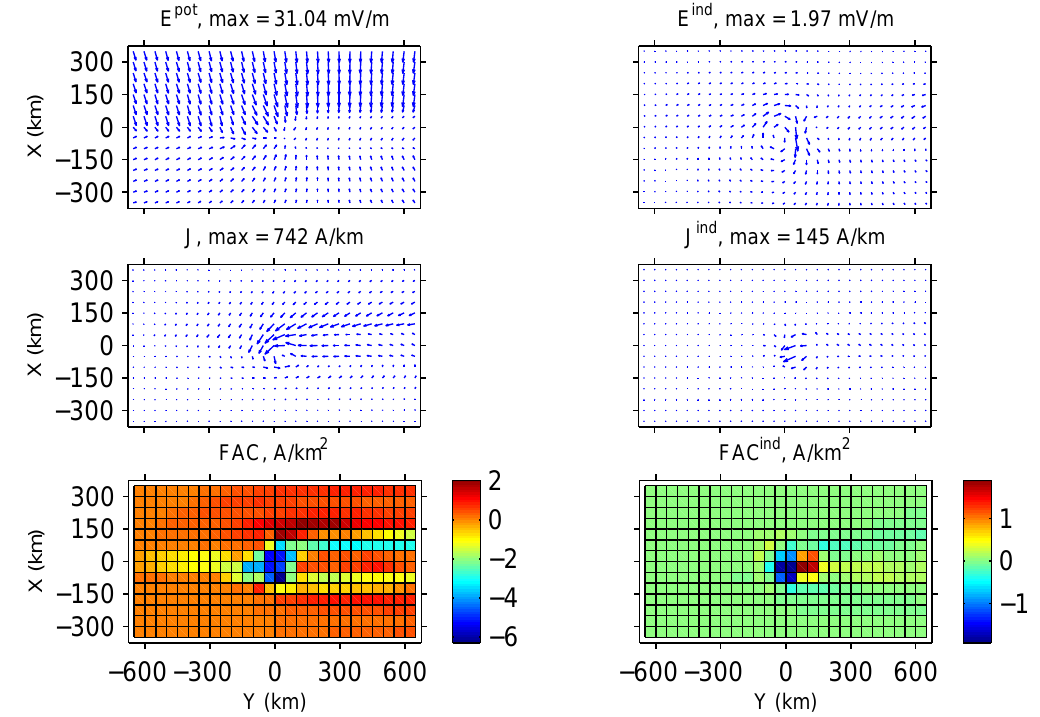
Fig. 13. Lefthand panels show the potential electric field and associated horizontal and field-aligned currents of the quasi-static westward traveling surge model. Righthand panels show the induced electric field and associated currents that are created when the WTS system is moving at 10kms − 1 westward. Modified from Fig. 8 of Vanham¨aki et al. (2007).